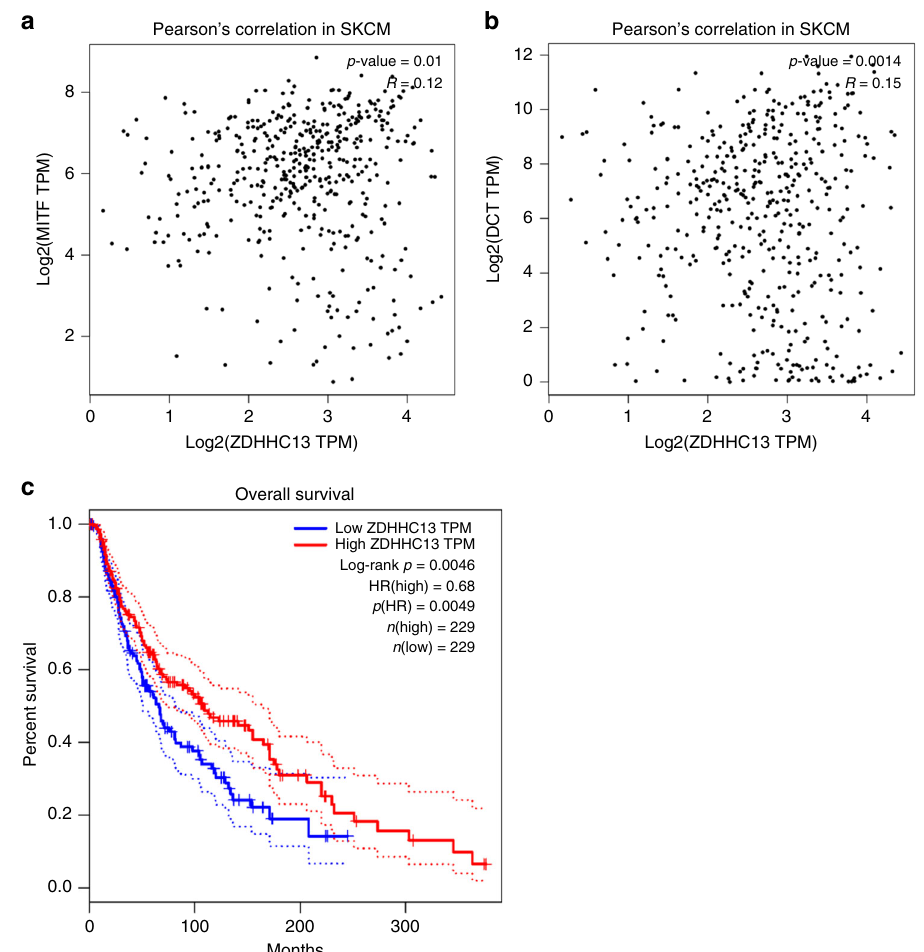
Fig. 1 Clinical relevance of ZDHHC13 and melanocortin-1 receptor signaling in human melanomas. a , b Pearson ’ s correlation between ZDHHC13 and MITF ( a ) or DCT ( b ) in The Cancer Genome Atlas (TCGA) SKCM. Plots show the Spearman ’ s correlation and MITF (left) or DCT (right) with ZDHHC13 mRNA level from RNA-seq data in TCGA melanoma calculated by GEPIA (Gene Expression Pro fi ling Interactive Analysis). R and p values are shown. c Melanoma patient survival analysis based on ZDHHC13 expression (cutoff = 50%). All patients in the TCGA melanoma study were divided according to the expression level of ZDHHC13 (higher or lower level than median expression value of all